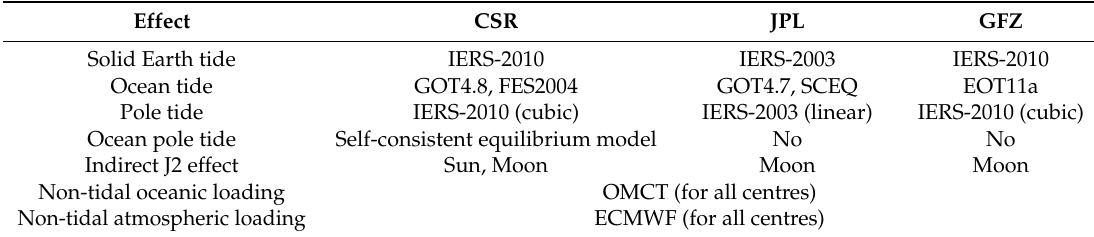
Table 1. The modelled effects used in the GSM products from three GRACE Science Data System (SDS) centres. CSR, Center for Space Research at University of Texas; GFZ, GeoForschungsZentrum Potsdam; IERS, International Earth Rotation and Reference Systems Service; GOT, global ocean tide; FES, finite element solutions; SCEQ, finite element solutions; EOT, empirical ocean tide model; OMCT, ocean model for circulation and tides.